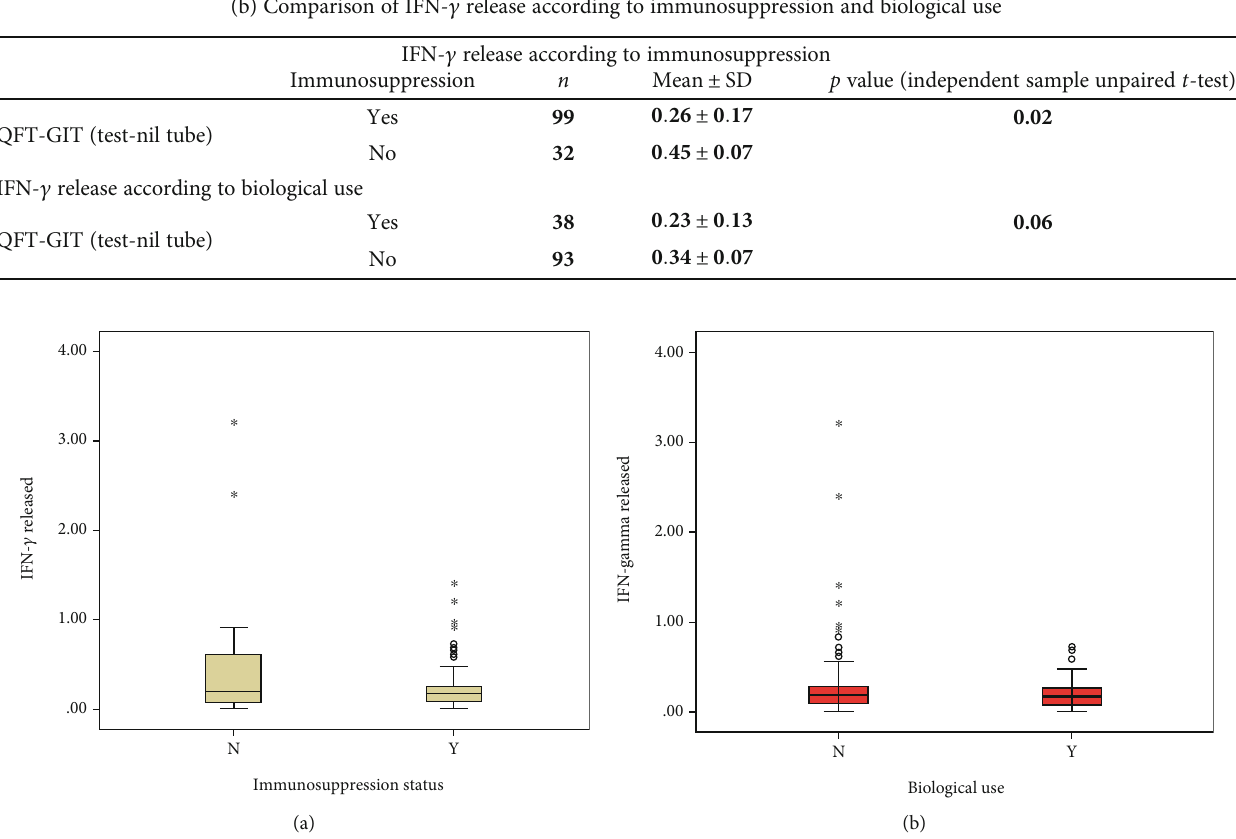
(b) Comparison of IFN- γ release according to immunosuppression and biological